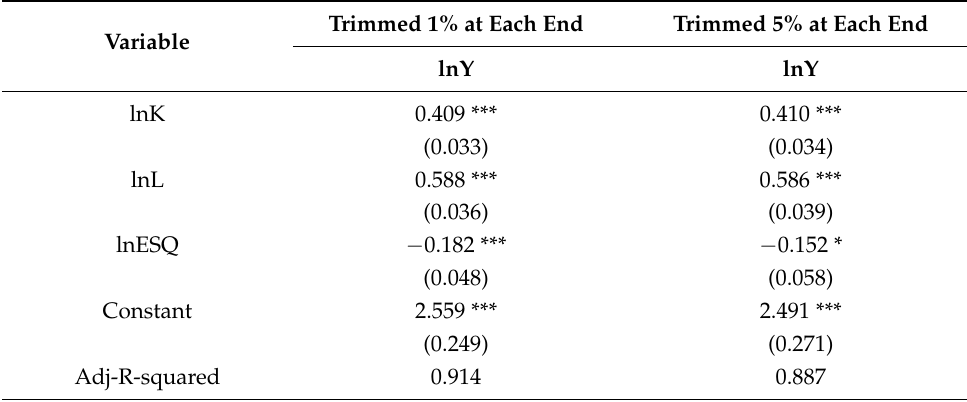
Table 5. OLS regression using trimmed